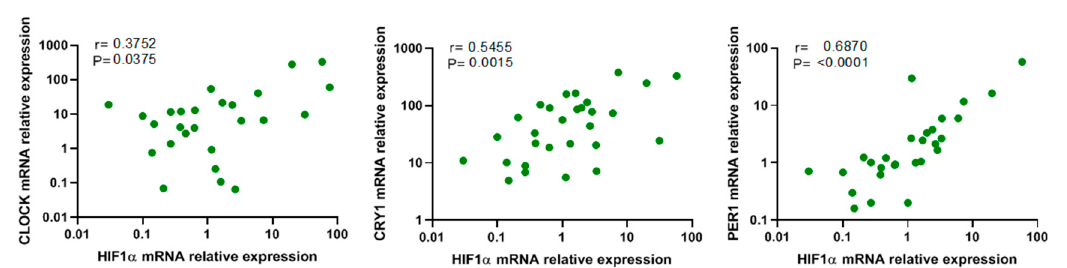
Figure 4. Circadian r hythm variation is related to HIF1 α expression. Correlation between HIF1 α mRNA expression and CLOCK ( n = 40 left panel), CRY1 ( n = 40, middle panel) and PER1 ( n = 40, right panel) mRNA expression in monocytes from OSA patients. The OSA patients were randomly selected. Spearman’s correlation coefficients (r) and p -values are shown.